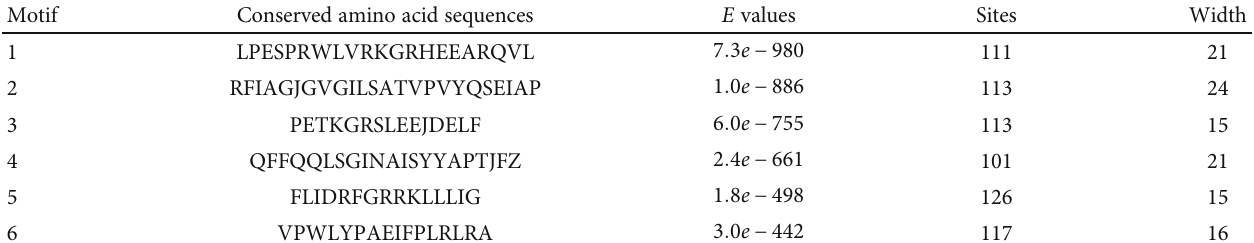
Table 2: The motifs identi fi ed in AoSUT proteins.